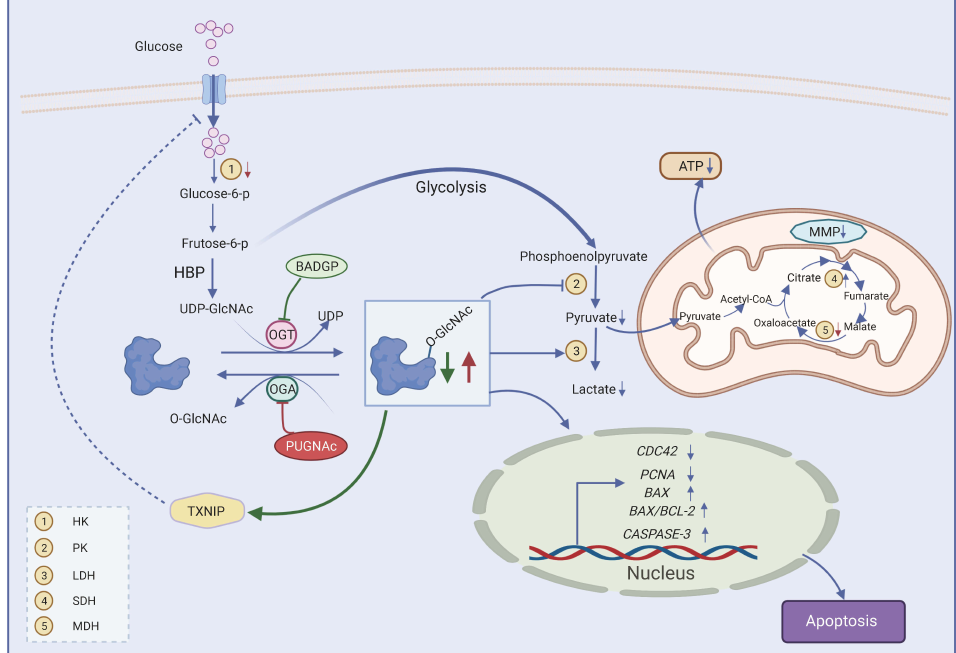
Figure 7. Proposed model for effects of dysregulated O-GlcNAcylation on GC function. Frutose- 6-p, fructose-6-phosphate; HBP, hexosamine biosynthetic pathway; O-GlcNAc, O-linked β -N- acetylglucosamine; OGT, O-GlcNAc transferase; OGA, O-GlcNAcase; UDP-GlcNAc, uridine-5 (cid:48) - diphosphate N-acetylglucosamine; BADGP, benzyl-2-acetamido-2-deoxy- α -D-galactopyranoside; PUGNAc, O-(2-acetamido-2-deoxy- D -gluco-pyranosylidene); TXNIP, thioredoxin-interacting pro- tein; TCA cycle, tricarboxylic acid cycle; MMP, mitochondrial membrane potential. Created with BioRender.com, accessed on 11 May